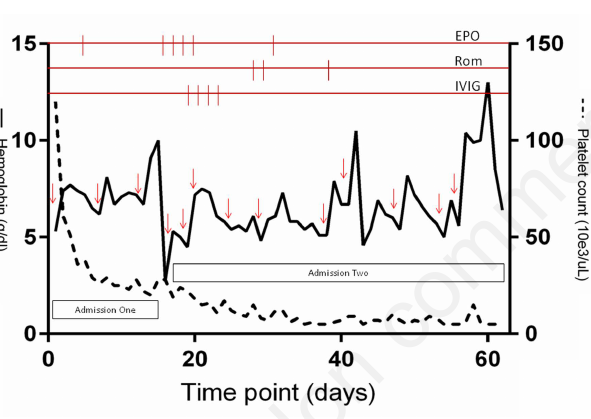
Figure 1. Changes in hemoglobin and platelet count over the patient’s two hospitalizations. Each red arrow represents a red cell transfusion event, and each red dash represents a dose of epoetin alpha (EPO), romiplostim (Rom), and intravenous immunoglob- ulin (IVIG). Table 1. Immuno-hematologic test results during the two hospitalizations.